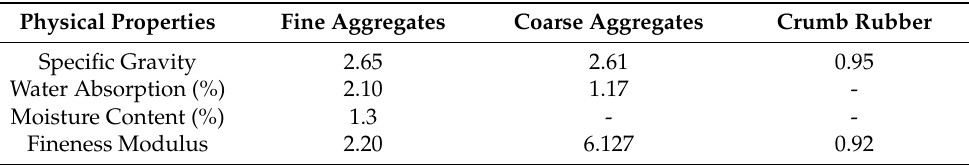
Table 1. Physical properties of aggregates and